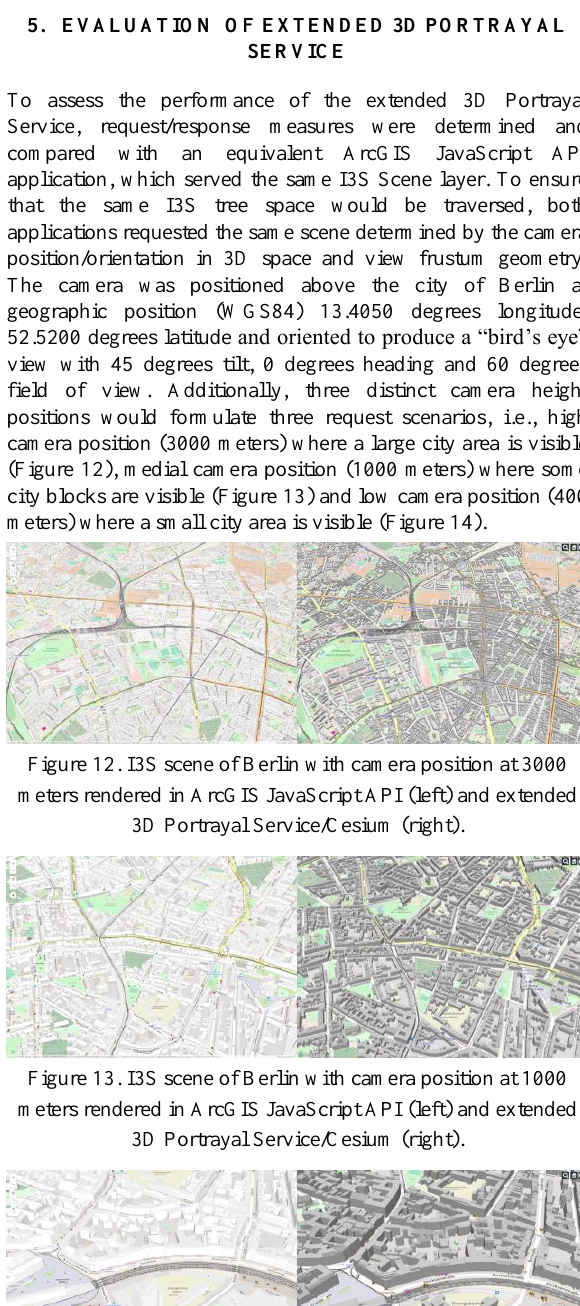
Figure 11. Extended 3D Portrayal request with additional parameters highlighted in blue.